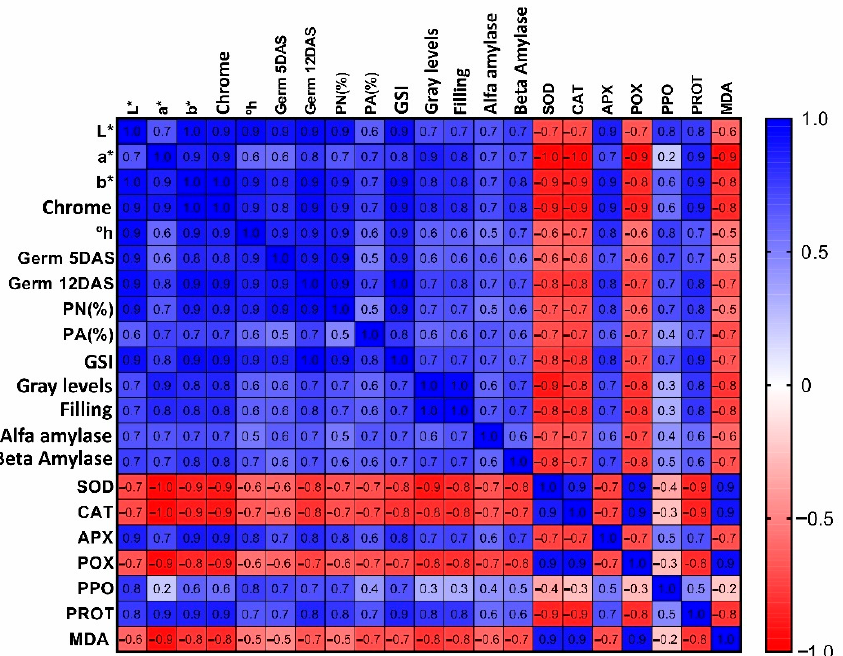
Figure 4. Heatmap plot of Pearson’s correlation for all the significant variables. L* (luminosity), a* (color index “a”), b* (color index “b”), Chrome, ◦ h (hue color angle), germ 5 DAS (germination percentage at five days after sowing), germ 12 DAS (germination percentage at thirteen days after sowing), PN (%) (percentage of normal seedlings), PA (%) (percentage of abnormal seedlings), GSI (germination speed index), gray levels, filling, alfa amylase, beta amylase, SOD (superoxide dismutase), CAT (catalase), APX (ascorbate peroxidase), POX (peroxidase), PPO (polyphenol oxidase), PROT (protein) and MDA (malondialdehyde).